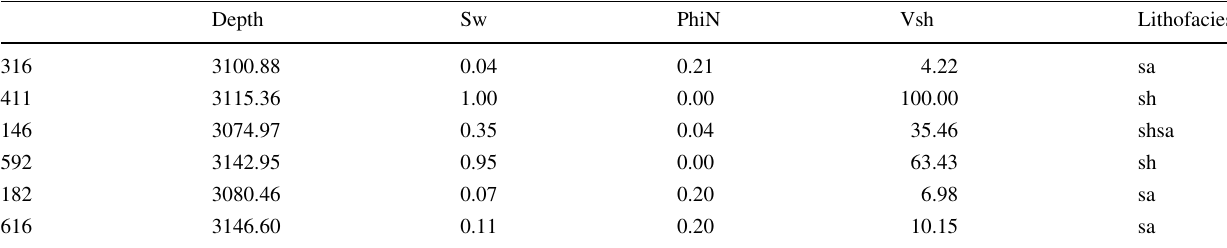
Table 3 Head of the sampled testing subset data for the well under study